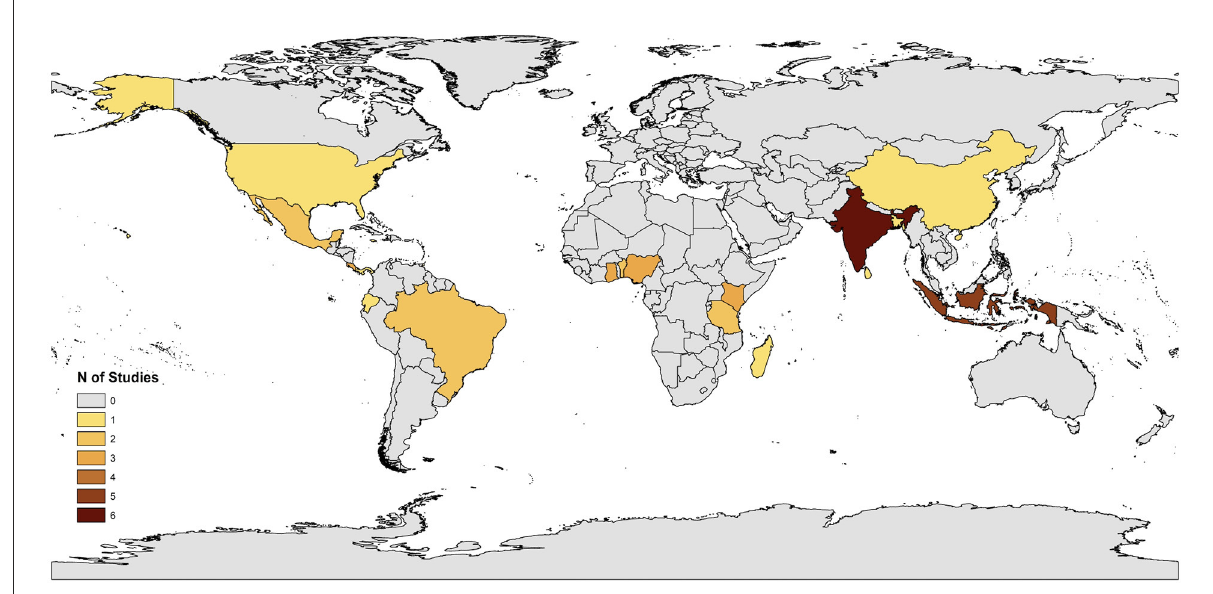
FIGURE4 Global distribution of published articles on the impacts of climate change on TAFS per